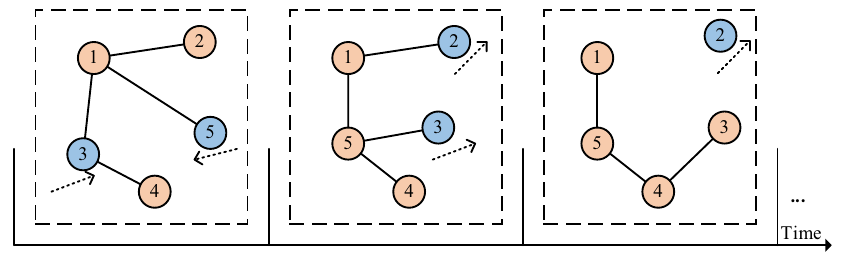
Figure 1. A brief model of